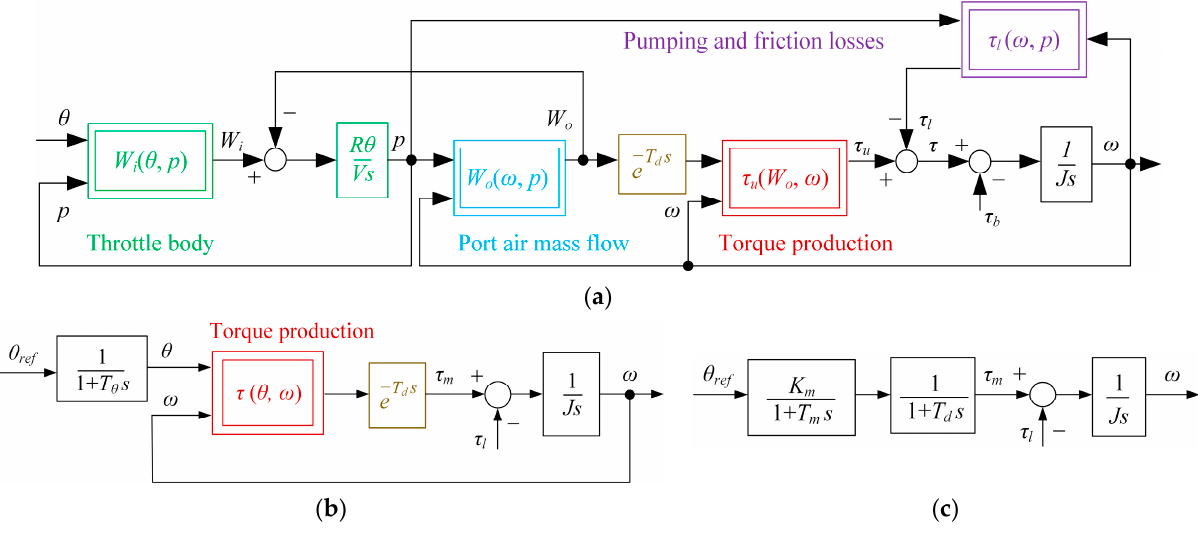
Figure 5. ICE modeling : ( a ) Non-linear mean value model of ICE; ( b ) simplified non-linear model of ICE; ( c ) model linearized in the vicinity of ICE operating point.